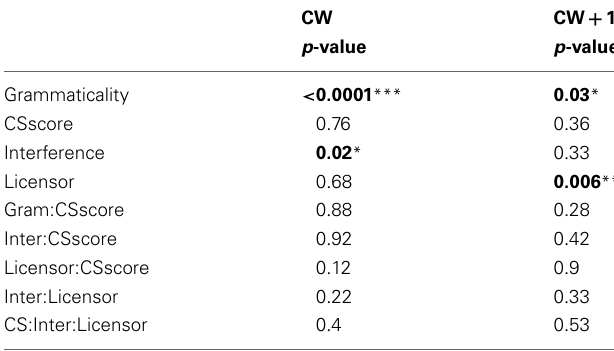
Table 5 | NPI licensing RTs: fixed effects from the maximal linear mixed effects model on the critical word and the spill-over